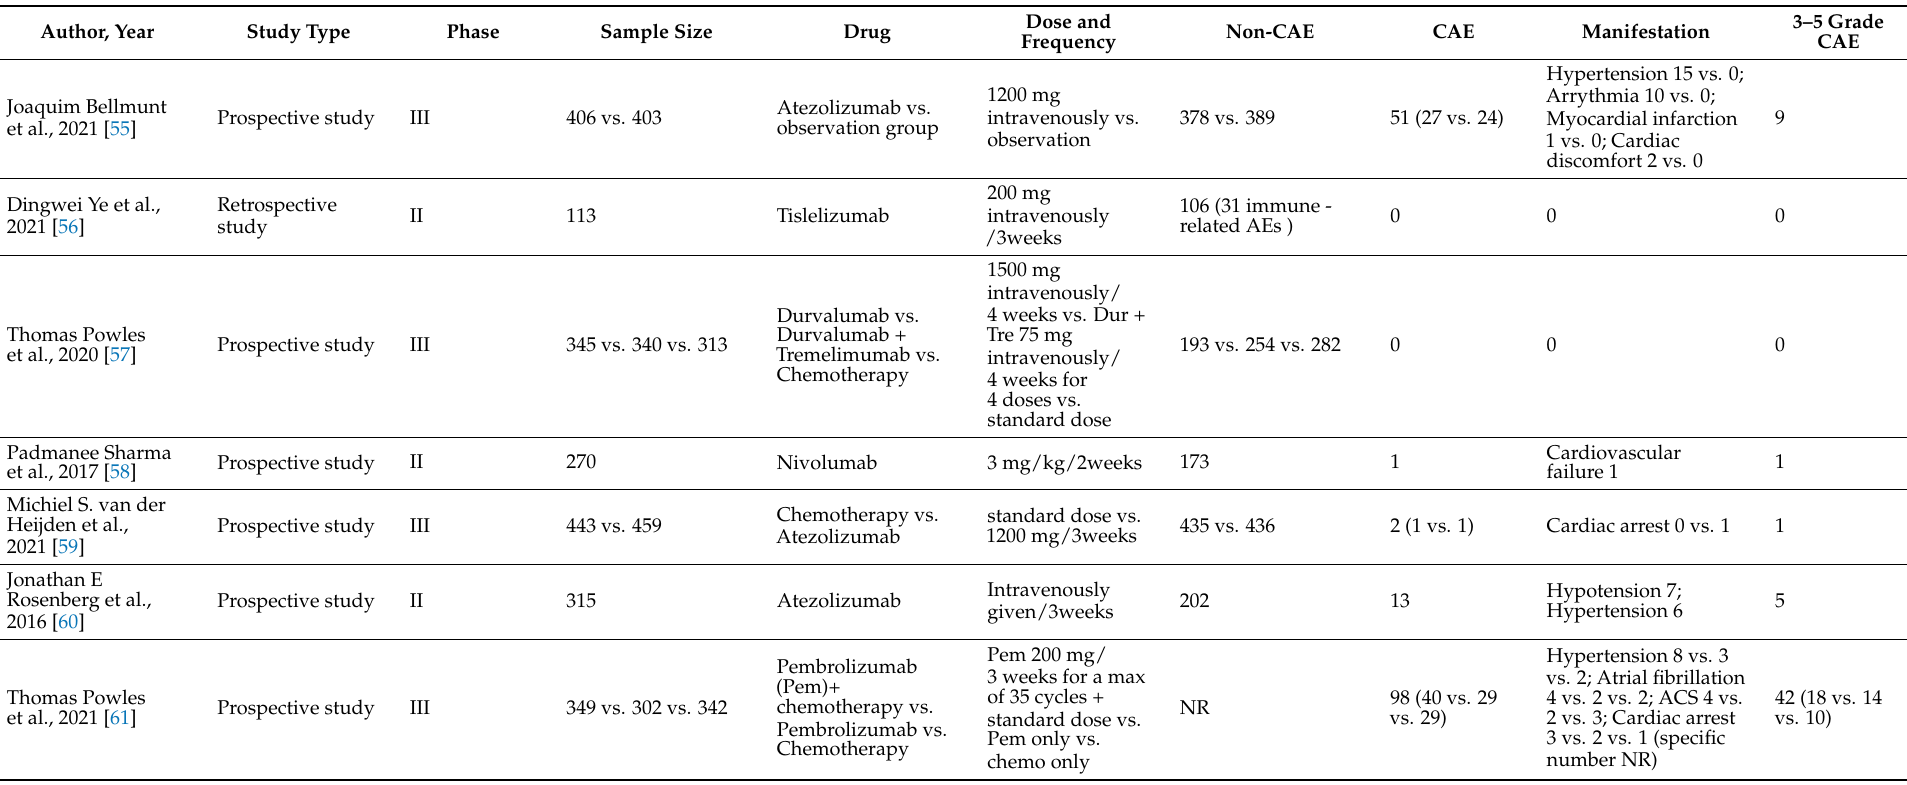
Table 4. Cardiotoxicity in urothelial